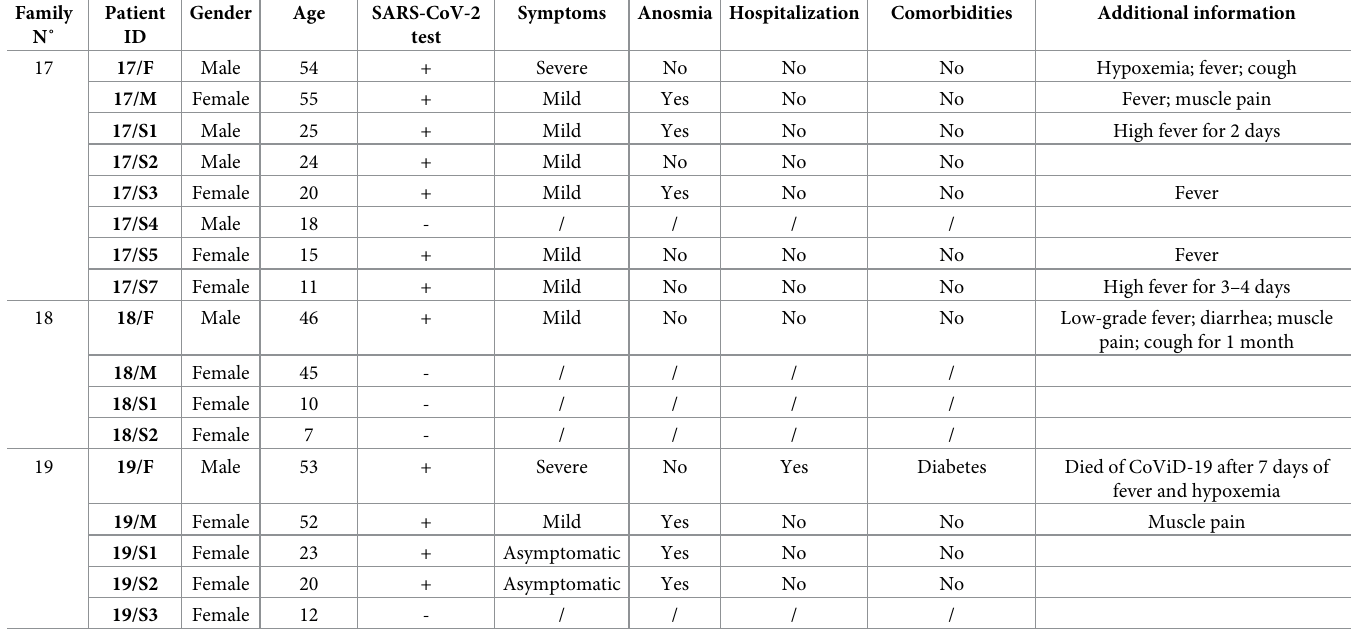
We included in the analysis 19 families for an overall number of 102 patients (55 female subjects and 47 male ones), of whom 35 were SARS-CoV-2 negative and 67 were SARS-CoV-2 positive. In particular, 12 out of 67 were asymptomatic patients, 39 out of 67 had a mild pheno- type of the disease and 16 out of 67 had severe symptoms. Finally, 28 out of 67 had anosmia/ ageusia. Patients’ age ranged from 6 to 83 years, with a mean age of 34,7 years (SD = 19,5), and 54% of the patients were female. The “COVID-19 positive” status or “COVID-19 negative” status represented a screenshot of the clinical situation during the exposure to the original SARS-CoV-2 spread and in the temporal window from October 2020 to December 2020, before the availability of any vaccine. Families were enrolled through a collaboration with the Haematological Transfusion Medicine Unit that was involved in recruitment of hyperimmune post COVID individuals. An informed written consent was collected, including a specific one for minors signed by parents. The local